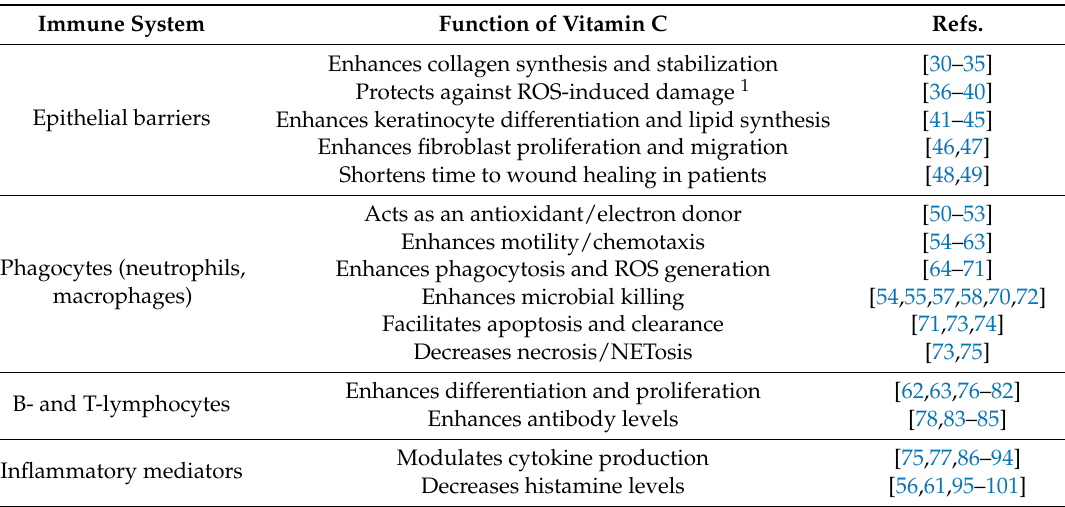
Table 1. Role of vitamin C in immune